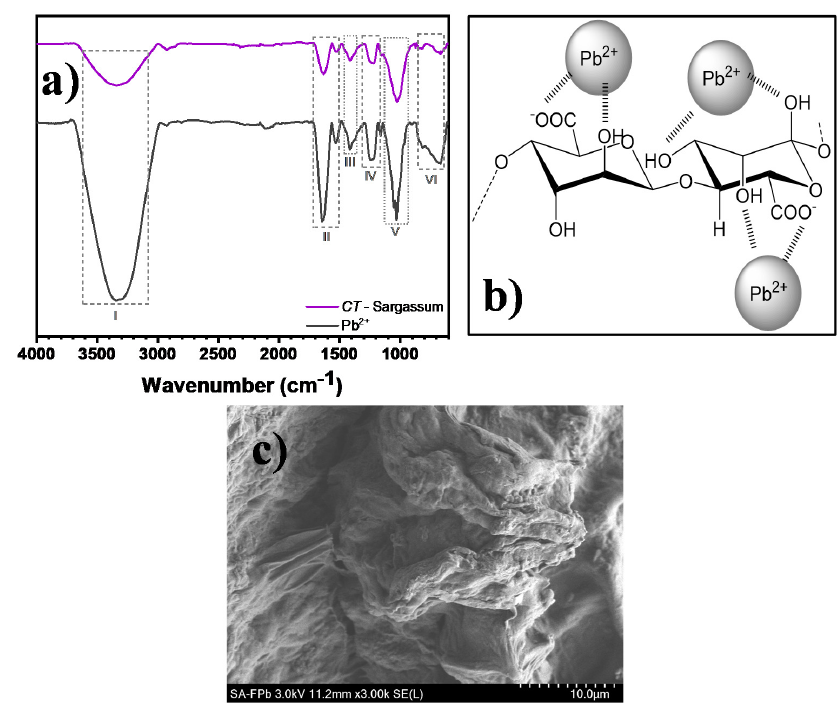
Figure 15. Analysis of CT- Sargassum spp. after Pb 2+ removal through the filtration system. ( a ) FTIR spectrum with six zones of interest marked, ( b ) proposed chelation scheme for Pb 2+ and the polysaccharides present in CT- Sargassum spp. and ( c ) SEM